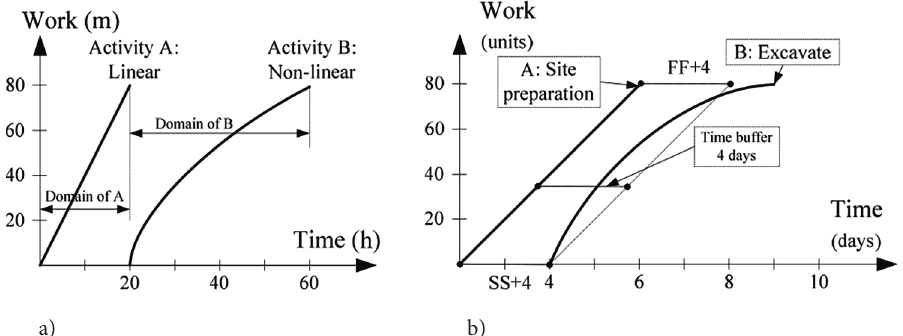
Figure 1. Activity function in trench